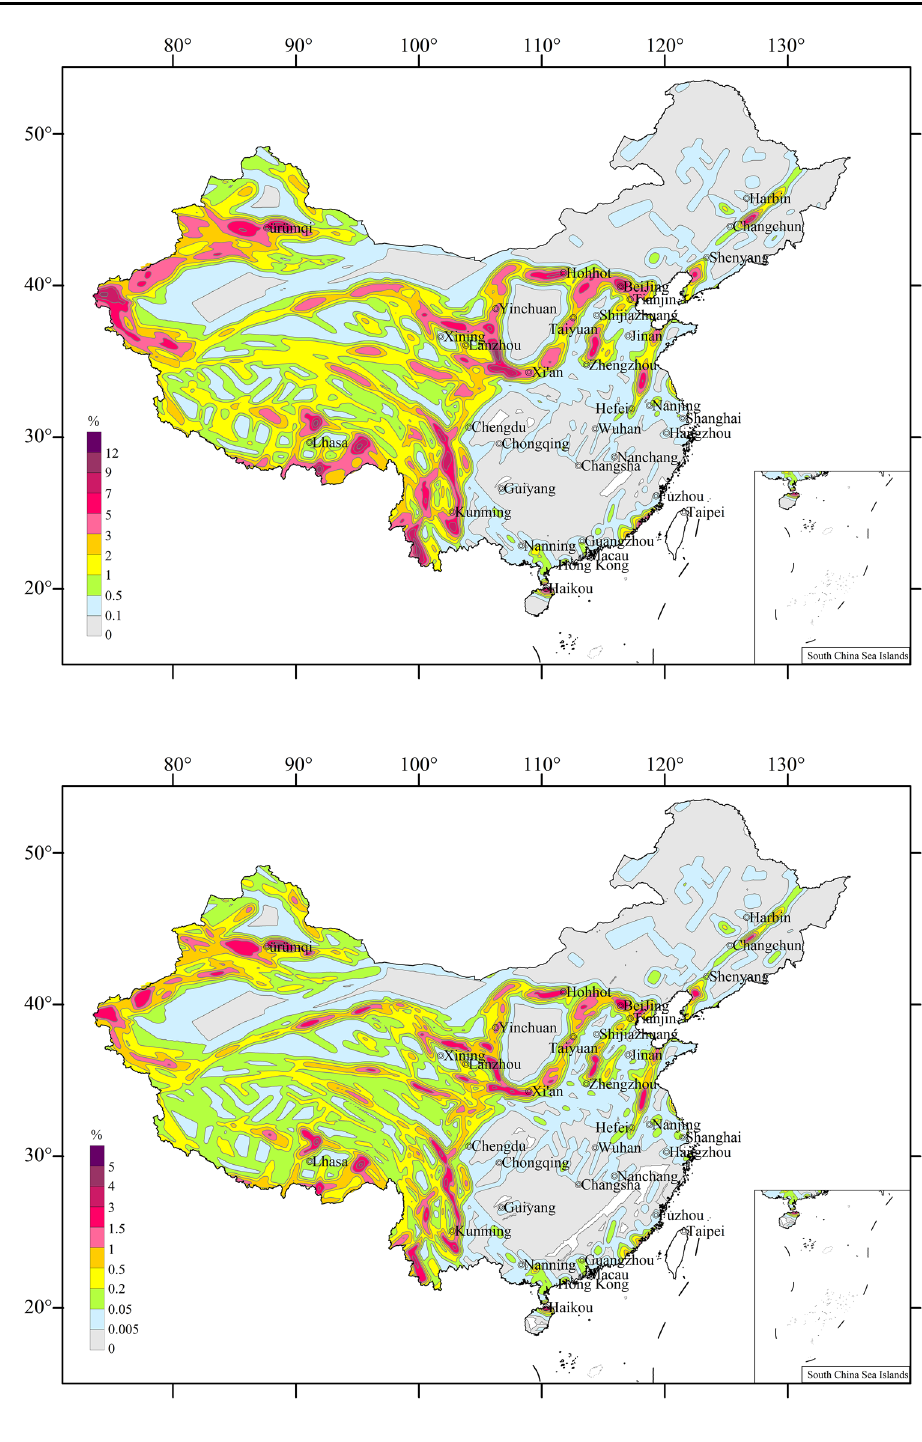
Fig. 11 Spatial distribution of the probability of the modified Mercalli intensity (MMI) VIII